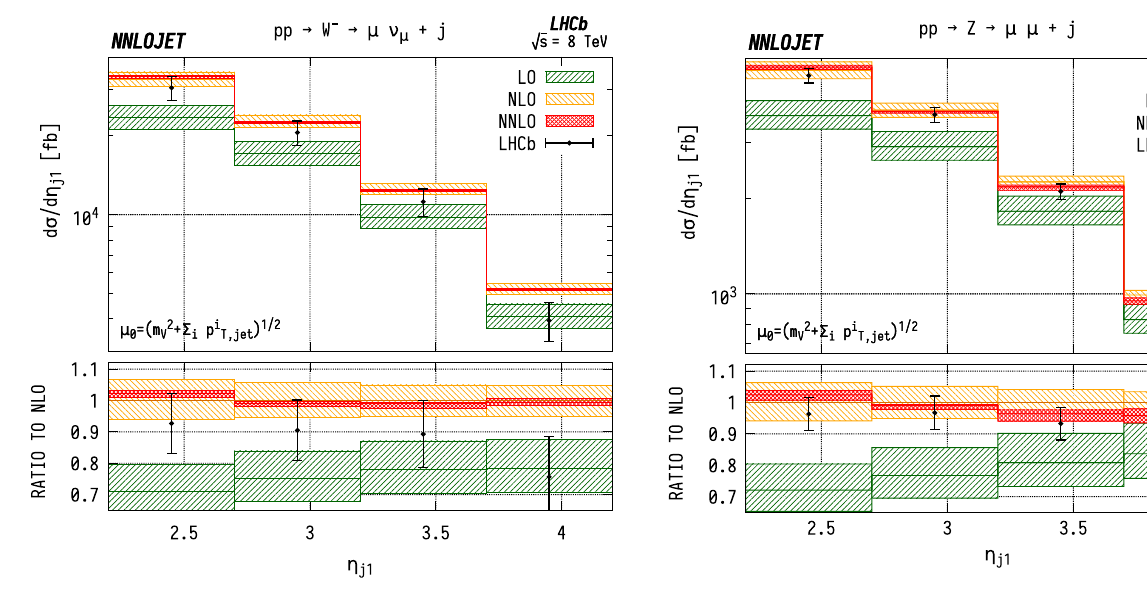
Fig. 6 Cross section differential in the pseudorapidity η of the leading jet for W − production. See Fig. 3 for details